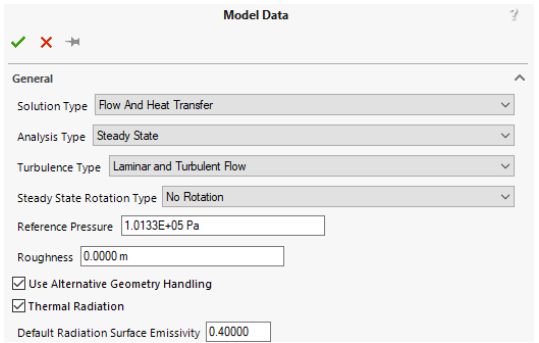
Figure 9. Model Data used in the FEA simulation.